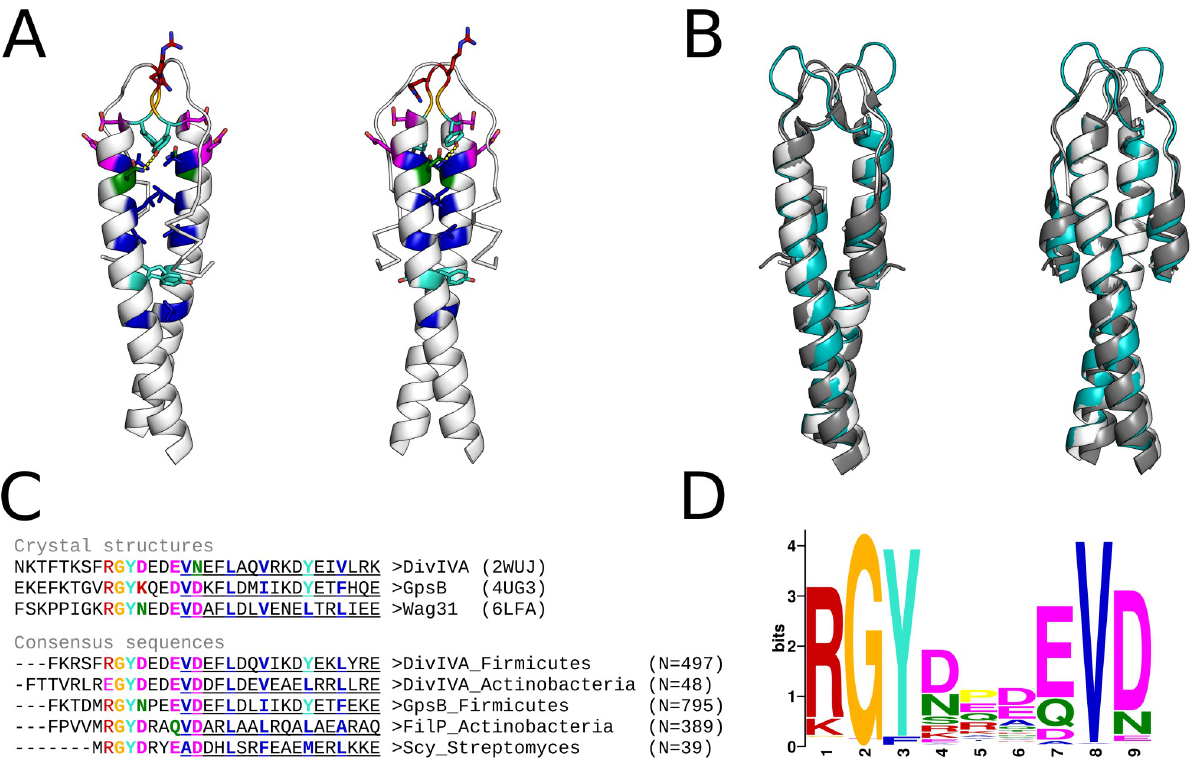
Fig 1. Summary of the DivIVA-like domain. (A) Cartoon renders of the DivIVA N-terminal domain (2WUJ); color-coded to match panel C, are the residues of the conserved motif as well as the core residues of the two following heptad coiled coils. (B) Superimposition of DivIVA (2WUJ, white), GpsB (4UG3, gray) and Wag31 (6LFA, teal); RMSD of the superimposition to 2WUJ is 1.0 and 2.2 Angstrom respectively. (C) Alignment of the sequences for the structures shown in panel B to the consensus sequences (N = number of sequences) of representatives for the major groups of DivIVA homologs (see Methods); the conserved motif and the core residues of the two following heptad coiled coils are highlighted in colors, and the Quick2D α -helical prediction is shown as underlined characters. (D) Logo representation of the top scoring motif found by MEME in the set of 1816 DivIVA homologs obtained as described in the